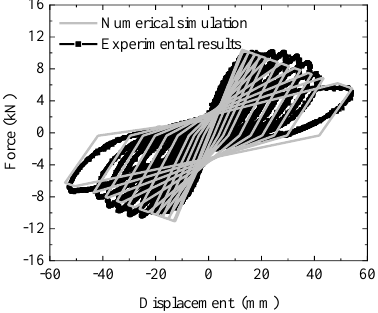
Figure 8. Verification of numerical models.